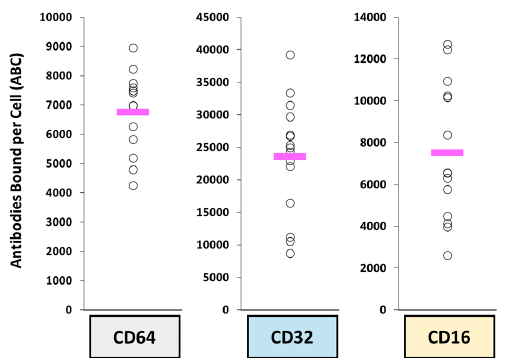
Figure 4. Variability in Fc G R expression on circulating monocytes (CD14+) in the blood of patients with metastatic breast cancer (mBC). CD64, CD32, and CD16 Fc G Rs were evaluated in each patient. Open circles and bars represent individual patient results and mean, respectively. This high interpa- tient variability in the expression of Fc G Rs on MPS cells in blood in consistent with the interpatient variability in the PK of mAbs and ADCs